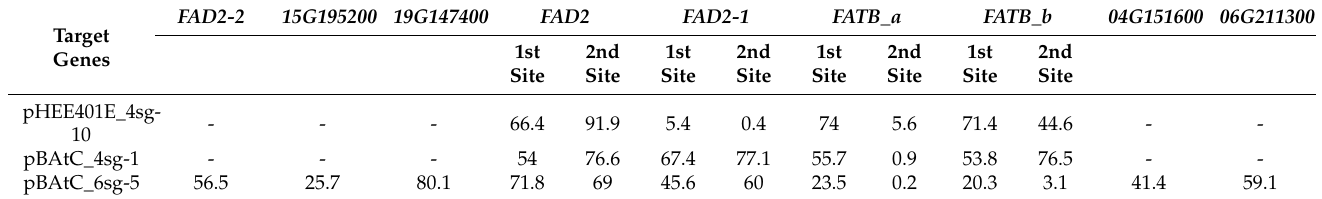
- indicates no indels detected. Ratio unit: percent (%).